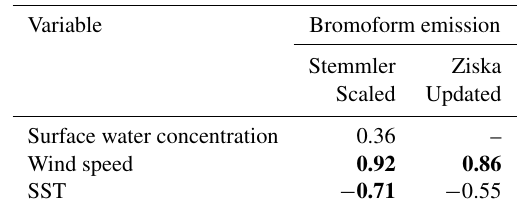
Table 2. Correlation between the annual cycle of bromoform emis- sion and bromoform surface water concentration, wind speed, and SST from Fig. 1 using Spearman rank correlation. Bold face corre- lations are significant at the 95% level according to a permutation test. Variables without an annual cycle (i.e., Ziska Updated surface water concentration and both atmospheric mixing ratios) could not be